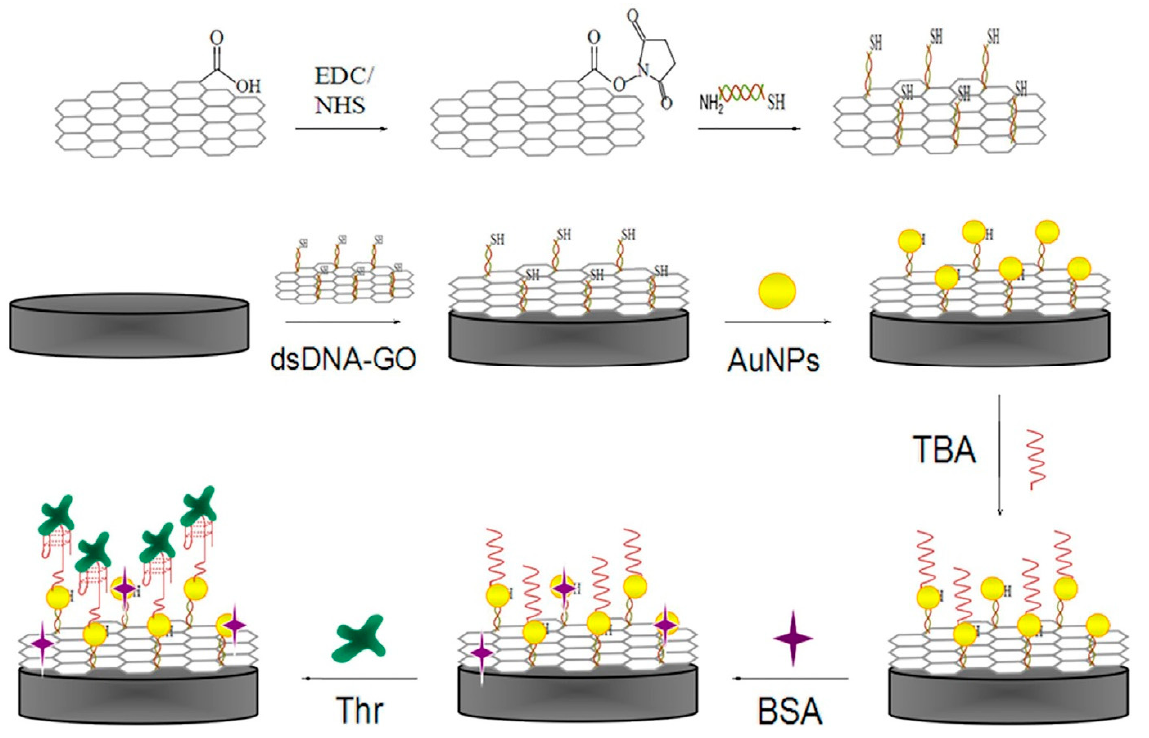
Figure 4. Step-wise formation of an impedance aptasensor for TB determination based on the AuNPs/dsDNA-GO nanocomposite [64].